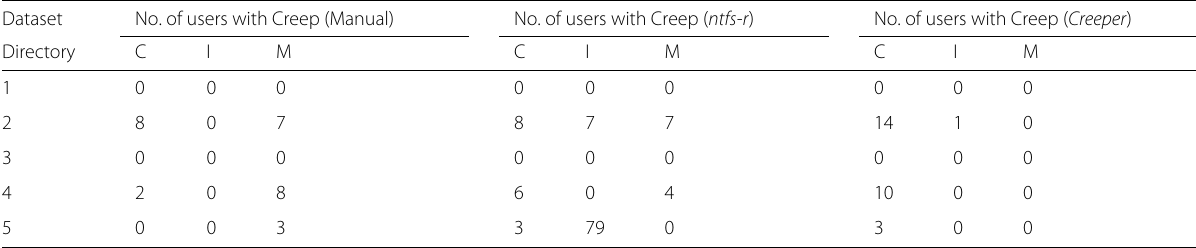
Table 7 Comparison of techniques